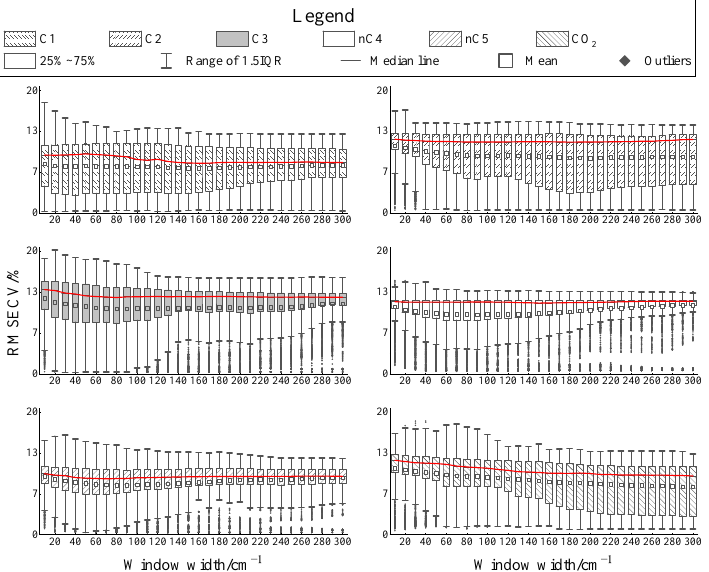
Figure 9. The influence of local modelling width on the quantitative analysis model of six substances. Obviously, the mean and median values of each substance changed gently under different window widths. From the change in the range of 25 ∼ 75% and 1.5 IQR, the stability of the C 1 ∼ C 5 models decreased, but it remained unchanged for CO 2 , when the window width increased gradually. It can be explained that the performance of local models for hydrocarbons may be more easily affected by irrelevant interference information